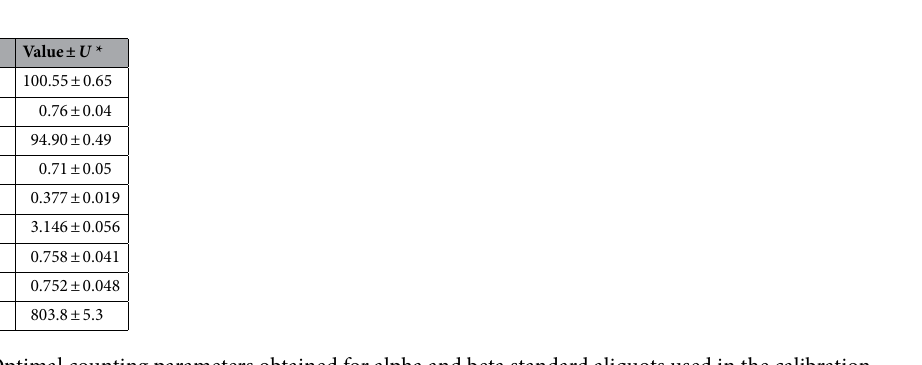
Table 2. Optimal counting parameters obtained for alpha and beta standard aliquots used in the calibration. * U is the expanded uncertainty corresponding to k = 1.